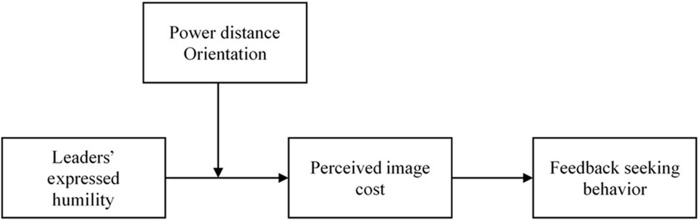
Theoretical model.